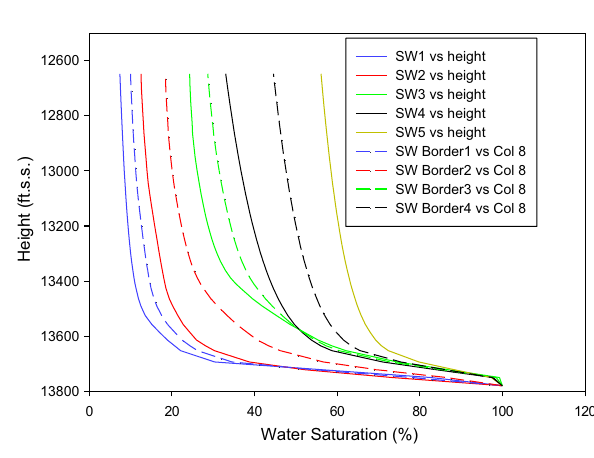
Fig. 12 Borders between different classes of rocks in capillary height curve plot. The borders are calculated as a function of depth using mentioned